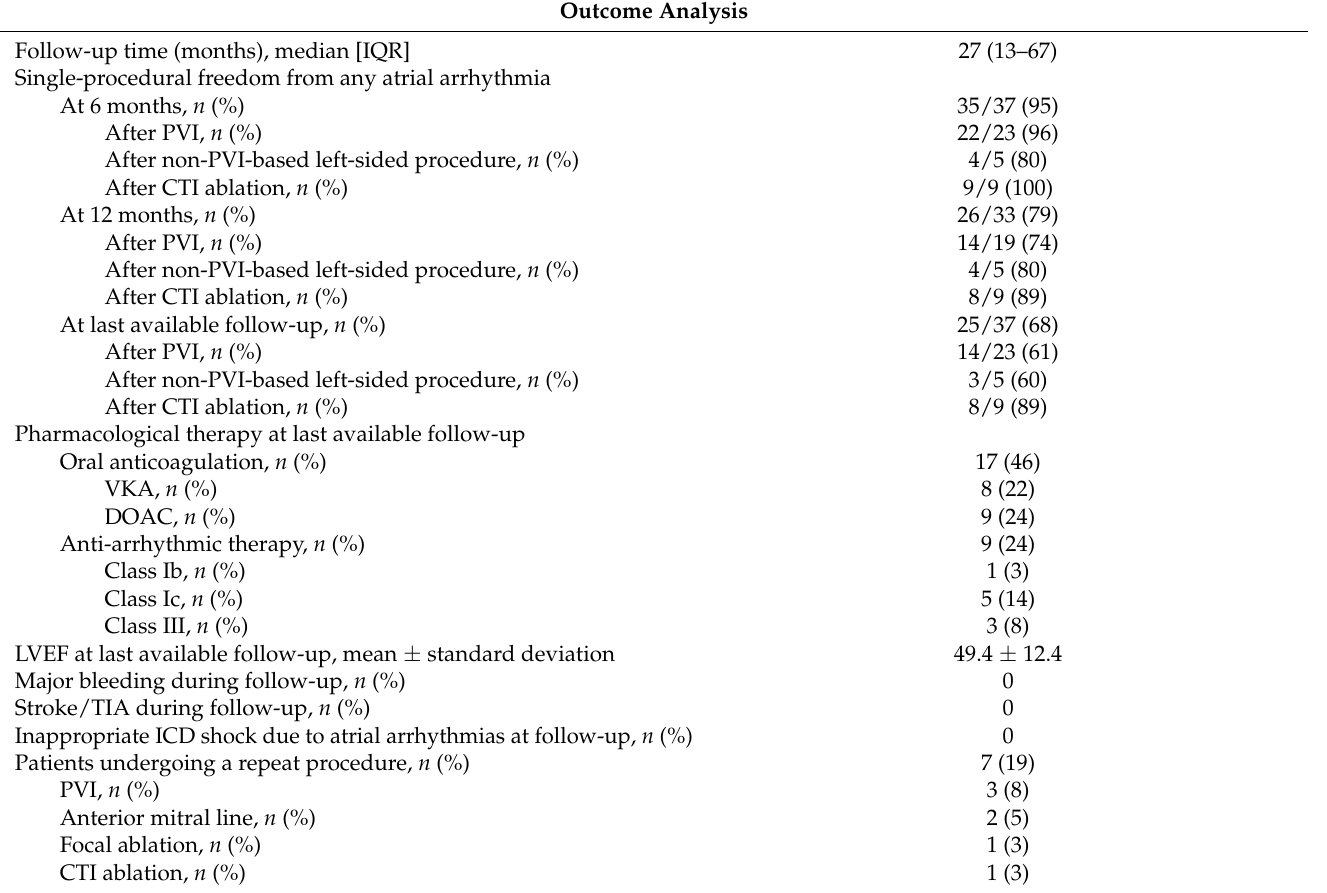
Table 4. Cohort outcomes at follow up. Outcome